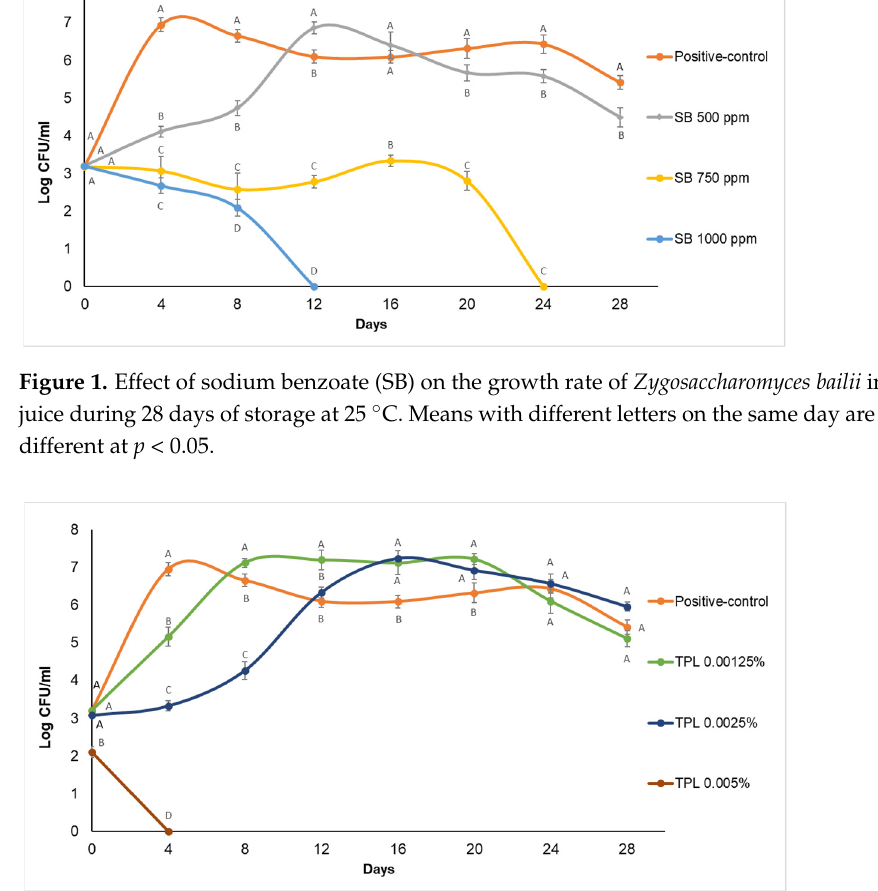
Figure 2. Effect of Tasmanian pepper leaf (TPL) nanoemulsion essential oil on the growth rate of Zygosaccharomyces bailii in clear apple juice during 28 days of storage at 25 °C. Means with different letters on the same day are significantly different at p < 0.05.